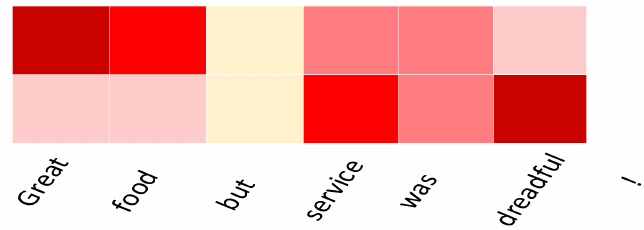
Figure 5. The visualized attention weights for the sentence and aspect term by